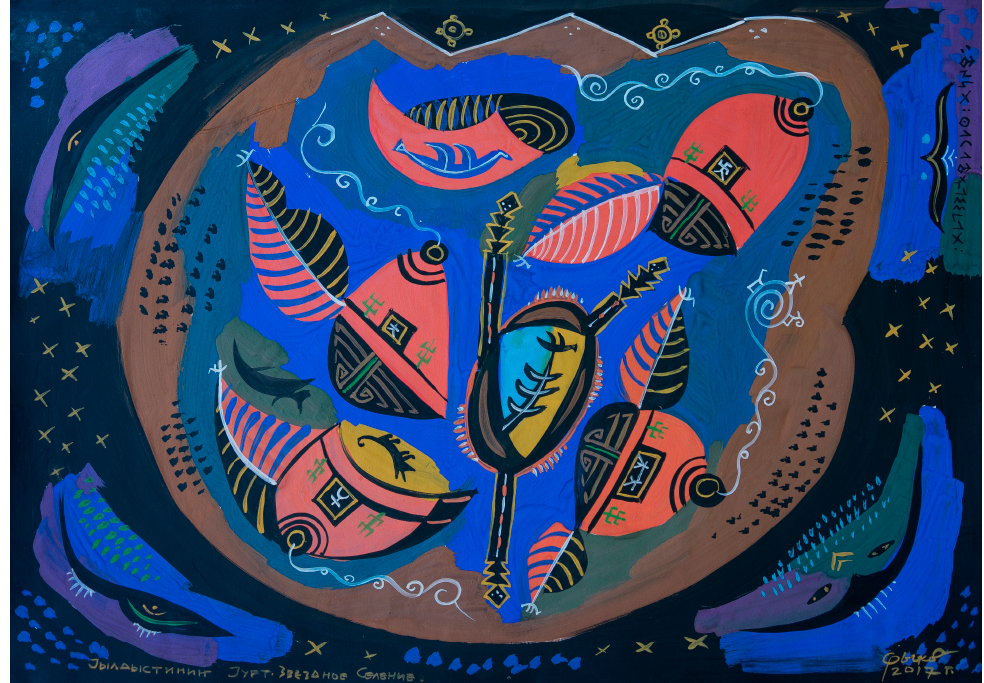
Figure 2. Sergei Dykov, Star Settlement , 2017, 43 × 61 cm, painting on paper. Photo: Andrzej Rozwadowski.